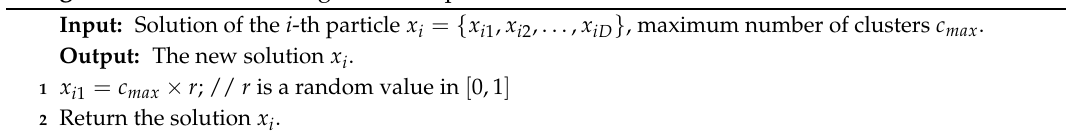
Algorithm 5: Transforming number